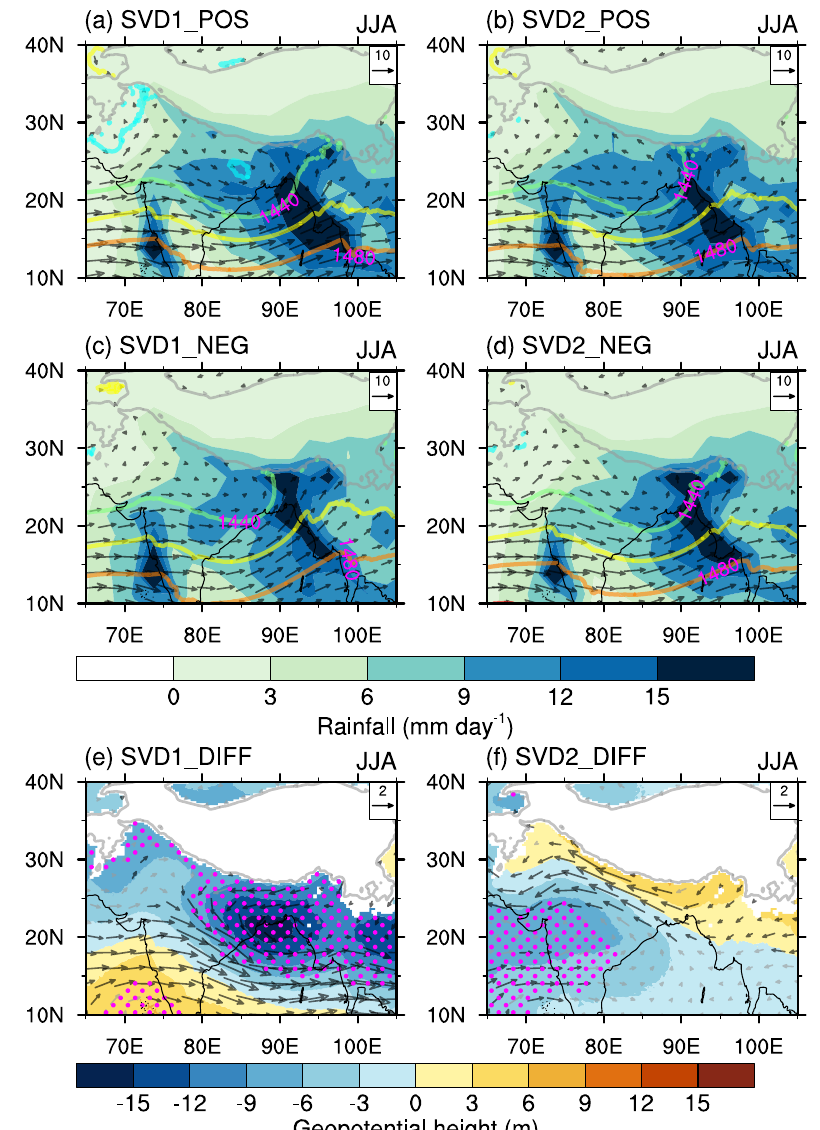
Fig. 2 | Atmospheric processes associated with the two leading singular value decomposition modes. Composite patterns of rainfall (mmday − 1 ; shading), 850- hPa wind (ms − 1 ; vector), and 850-hPa geopotential height (m; contour) in a , b positive and c , d negative years with respect to the principal components of